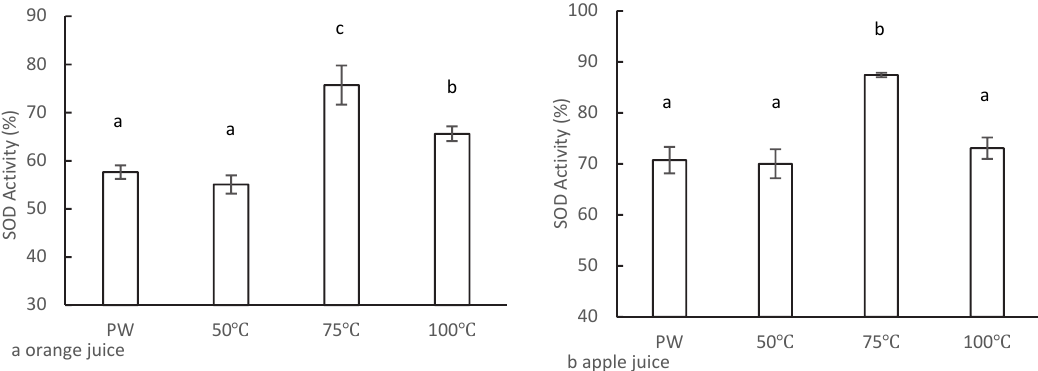
Figure 3. The effect of TMW with different tourmaline stone treatment temperature on SOD activity of 50% Tropicana juice; ( a ) orange juice; ( b ) apple juice. PW is pure water (control); 50~100 ◦ C is the treatment temperature of tourmaline stone. The different letters indicated significant difference ( p < 0.05).